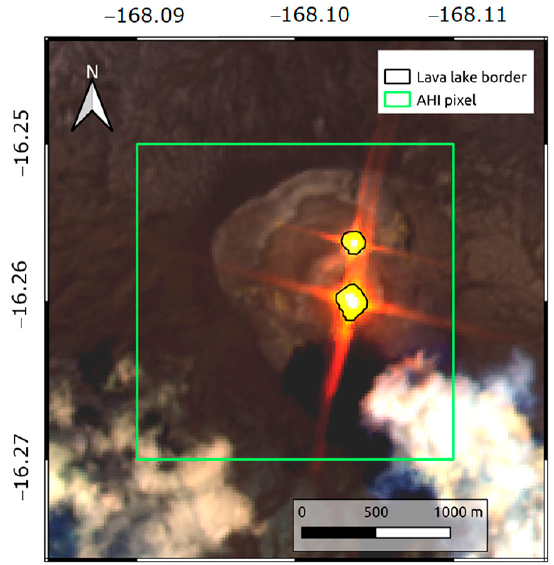
Figure 8. RGB (Red = Band 12: Green = Band 11; Blue = Band 8A) S2-MSI imagery of 25 November 2018 at 23:09 UTC and AHI pixel, in green, including the Benbow crater. The hottest portion of the lava lakes (in yellow on the RGB with the lava lake borders marked in black) covered an area of about 55,650 m 2 ( ≈ 1.1% of the AHI pixel area).